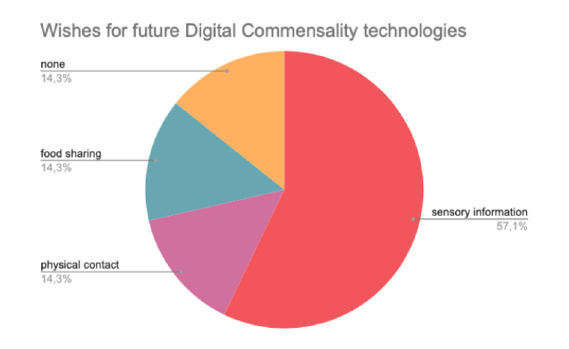
FIGURE3 Wishes for future Digital Commensality technologies.